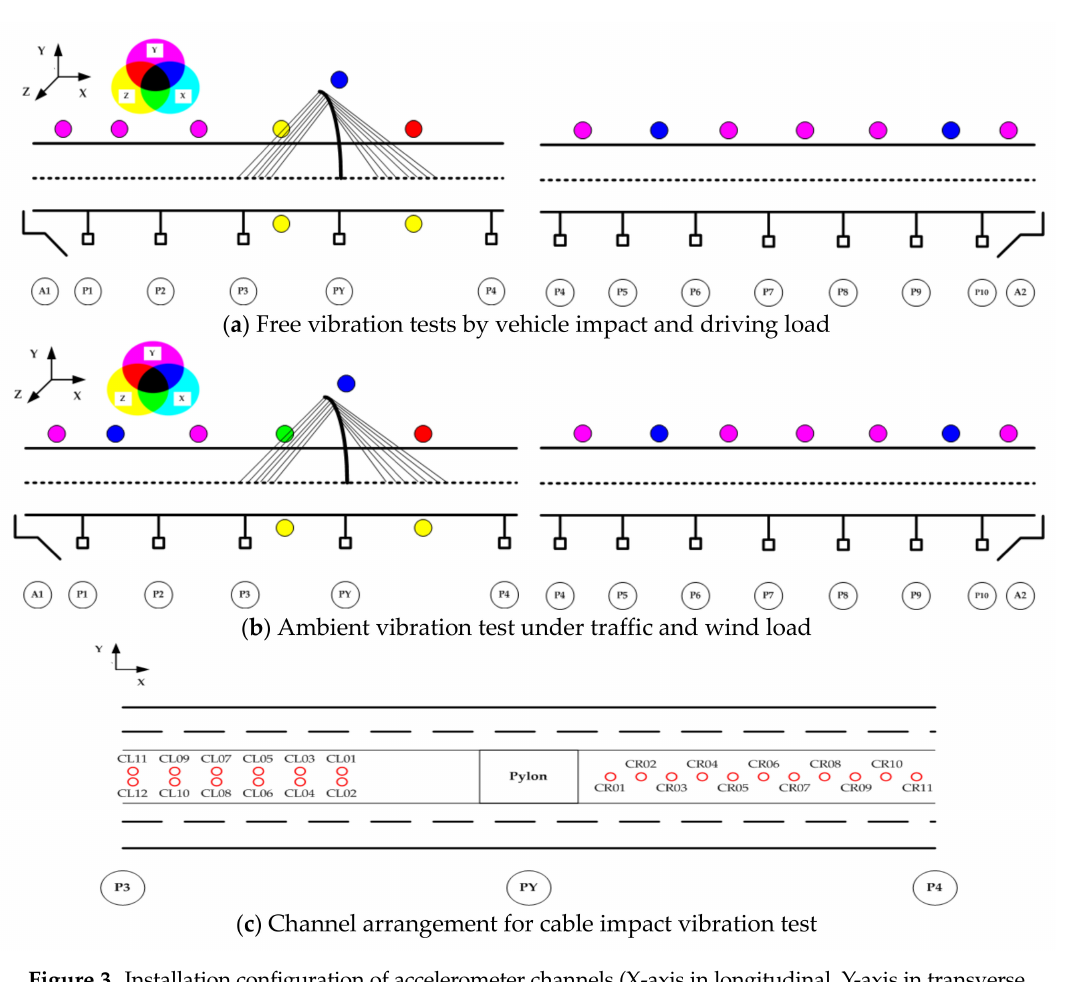
Figure 3. Installation configuration of accelerometer channels (X-axis in longitudinal, Y-axis in transverse, Z-axis in orthogonal). ( a – c ) Acceleration seonsors’ installations for vibration